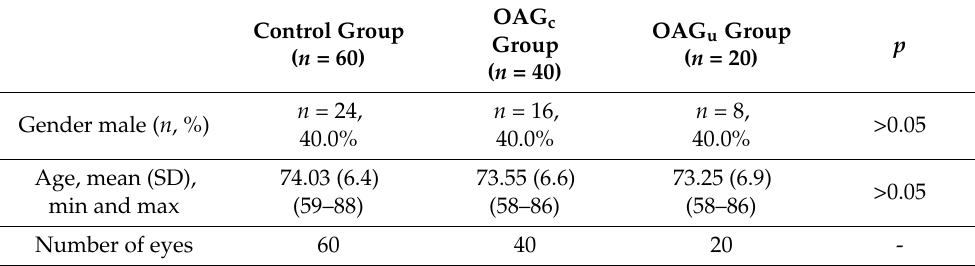
Table 1. Demographic data of the subjects.